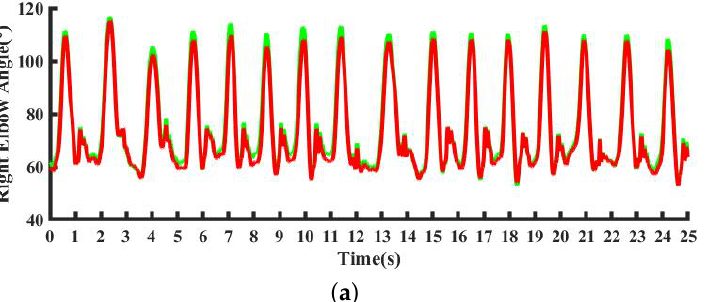
Figure 14. Comparison flexsion angle curve. ( a ) right elbow joint. ( b ) left elbow joints. The red curve is obtained by OptiTrack, and the green curve is obtained by the self-made system.